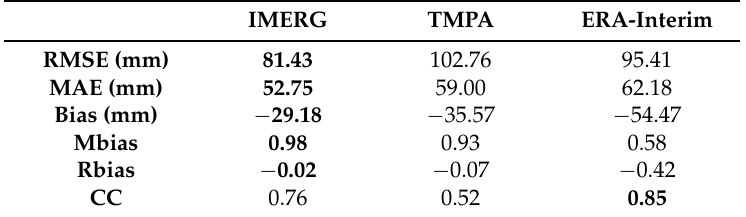
Table 8. Statistical indices of monthly precipitation in Guilan area (mid-March 2014 to February 2015).